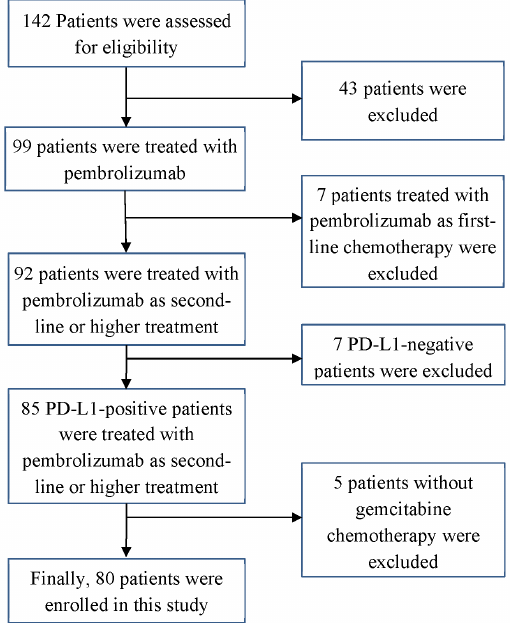
Figure 1. Patient flowchart. A total of 142 patients were screened, and, finally, 80 were enrolled in this study based on the inclusion and exclusion criteria for patients. PD-L1, programmed cell death- ligand